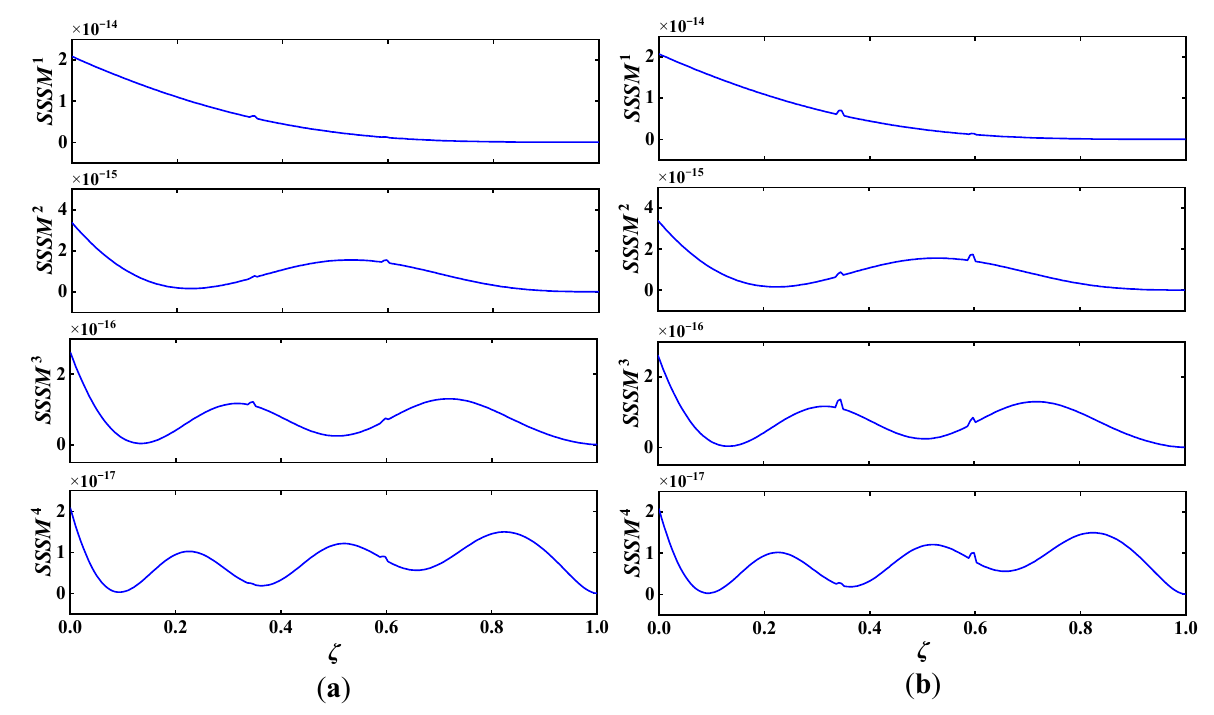
Figure 10. The first four order SSSM of the cracked cantilever beam: ( a ) scenario I; ( b ) scenario II.